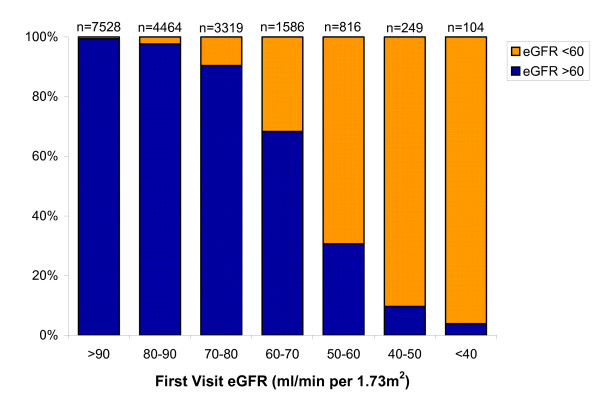
Proportion of individuals with eGFR < 60 mL/min per 1.73m2 or ≥ 60 mL/min per 1.73m2 at their second study visit stratified by the initial eGFR. GFR is estimated using the 4-variable MDRD equation. The x-axis refers to the eGFR at the first study visit while the y-axis identifies the proportion of individuals with that initial eGFR who had a second visit eGFR above and below 60 mL/min per 1.73m2. 'n' refers to the number of participants in each eGFR group at the first study visit.